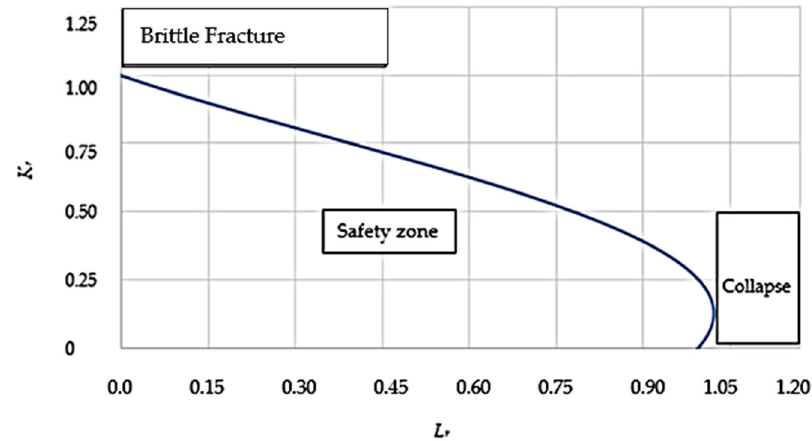
Figure 3. Failure assessment diagram.